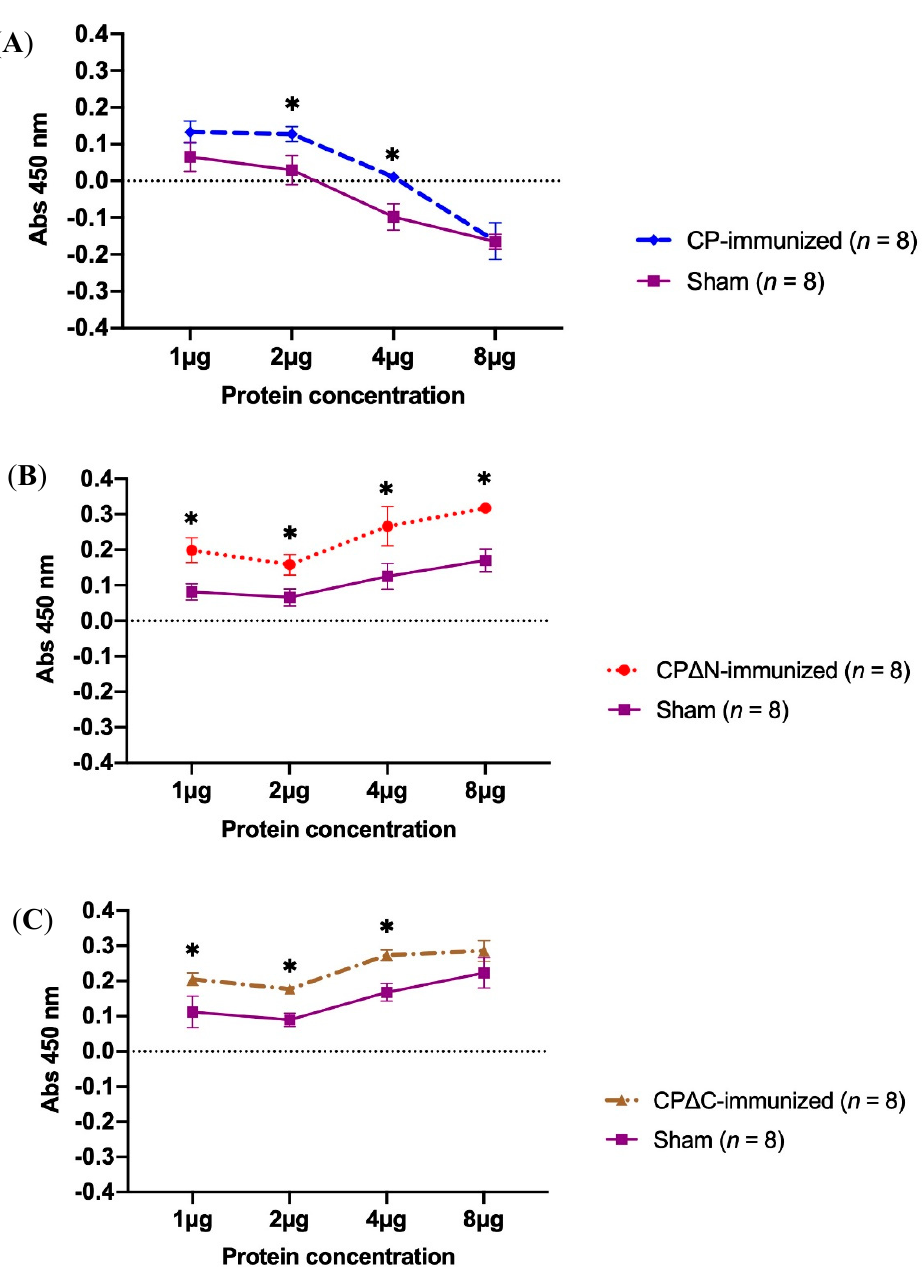
Figure 3. Proliferation assay of mice splenocytes after re-stimulation with di ff erent concentrations of the corresponding MAstV capsid proteins. The MAstV vaccine candidates (5 µ g / mouse) combined with an equal volume of AbISCO-100 adjuvant (10 µ g / mouse) were injected to NMRI mice ( n = 8 per group, 4 weeks old) twice with a three-week interval. Mice injected with pDual-GC-vector-transfected cell lysate combined with adjuvant were also analyzed as sham ( n = 8). Three weeks after the second immunization, the splenocytes were harvested from all mice groups: ( A ) CP-immunized ( n = 8), ( B ) CP ∆ N-immunized ( n = 8), and ( C ) CP ∆ C-immunized ( n = 8). The splenocytes were then purified, cultivated ex vivo (2 × 10 5 cells / well), and stimulated by exposing to di ff erent final concentrations (1 µ g, 2 µ g, 4 µ g, and 8 µ g) of the corresponding MAstV CPs as described in Materials and Methods; cell proliferation was measured in a WST-1 assay after 48 h of incubation. The splenocytes of the sham group ( n = 8) were also independently exposed to each of the three MAstV CPs. The data are mean COD value readings of triplicate experiments. Asterisks indicate a significant di ff erence at the given protein concentration between immunized and sham mice tested by two-way ANOVA with replication test (* p < 0.05). Error bars represent standard deviation (SD).